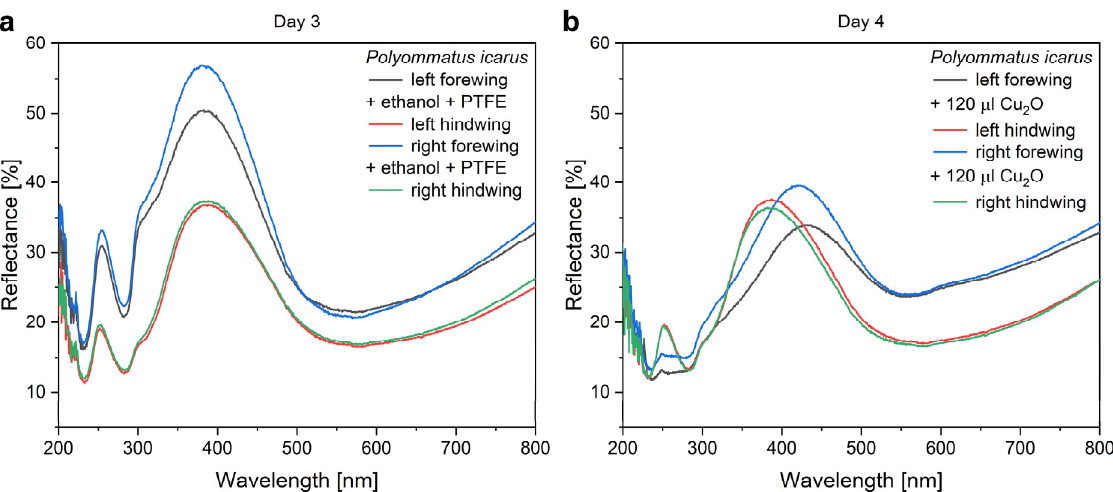
Figure 4. The modification of the optical properties of type-1 samples after the application of 120 μ L of Cu 2 O sol onto the wing. ( a ) Two wings after PMMA gluing onto glass, two wings after the ethanol pretreatment followed by mounting of the PTFE frame. ( b ) The ethanol-pretreated wings received the 3 × 40 μ L Cu 2 O sol.